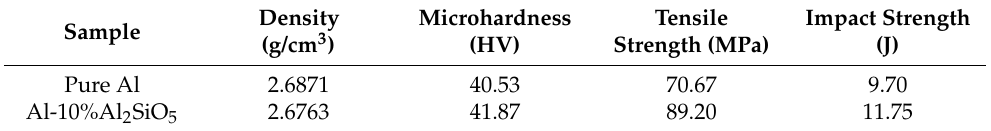
Table 1. Properties of the studied